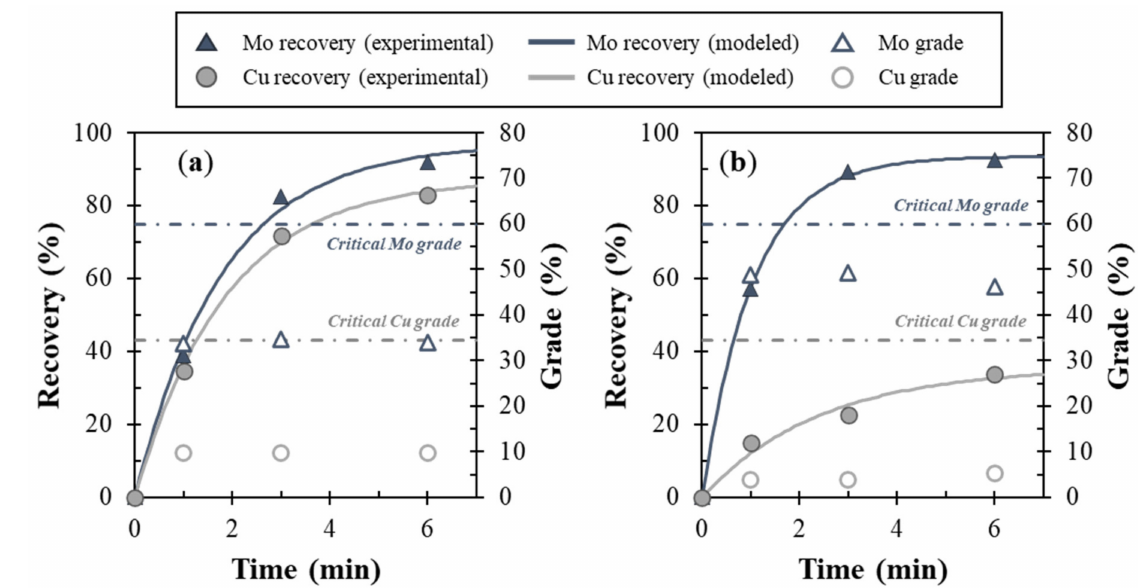
Figure 7. Effect of ME treatment on the floatability of chalcopyrite and molybdenite in the mixed mineral flotation: ( a ) untreated and ( b ) treated chalcopyrite/molybdenite mixture. Note that makers indicate experimental data while lines denote calculated values based on the first-order flotation kinetic model (Equation (4)).